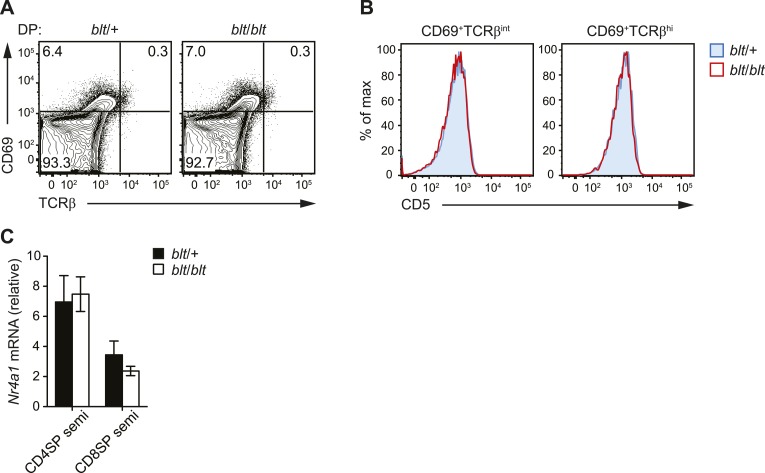
blt/blt mice exhibit intact positive and negative selection in the
thymus.(A) Surface expression of CD69 and TCRβ on DP thymocytes
from blt/+ and blt/blt
mice with a polyclonal TCR repertoire. Positively selected DP thymocytes
are CD69hiTCRβint. (B) CD5 surface
expression on CD69hiTCRβint and
CD69hiTCRβint post-positive selection
populations, gated on total live thymocytes. (C)
Quantitative RT-PCR analysis of Nr4a1 (Nur77) mRNA in
FACS-purified CD4 and CD8 semi-mature SP thymocytes (mean ± s.d.,
n = 3).